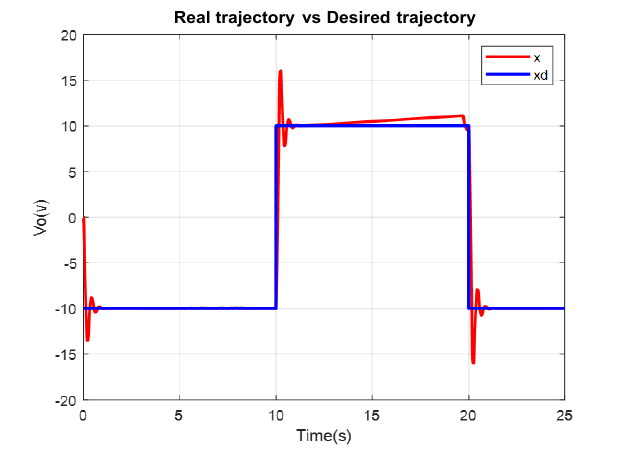
Figure 7. Conventional PID Real versus desired trajectory (position change).